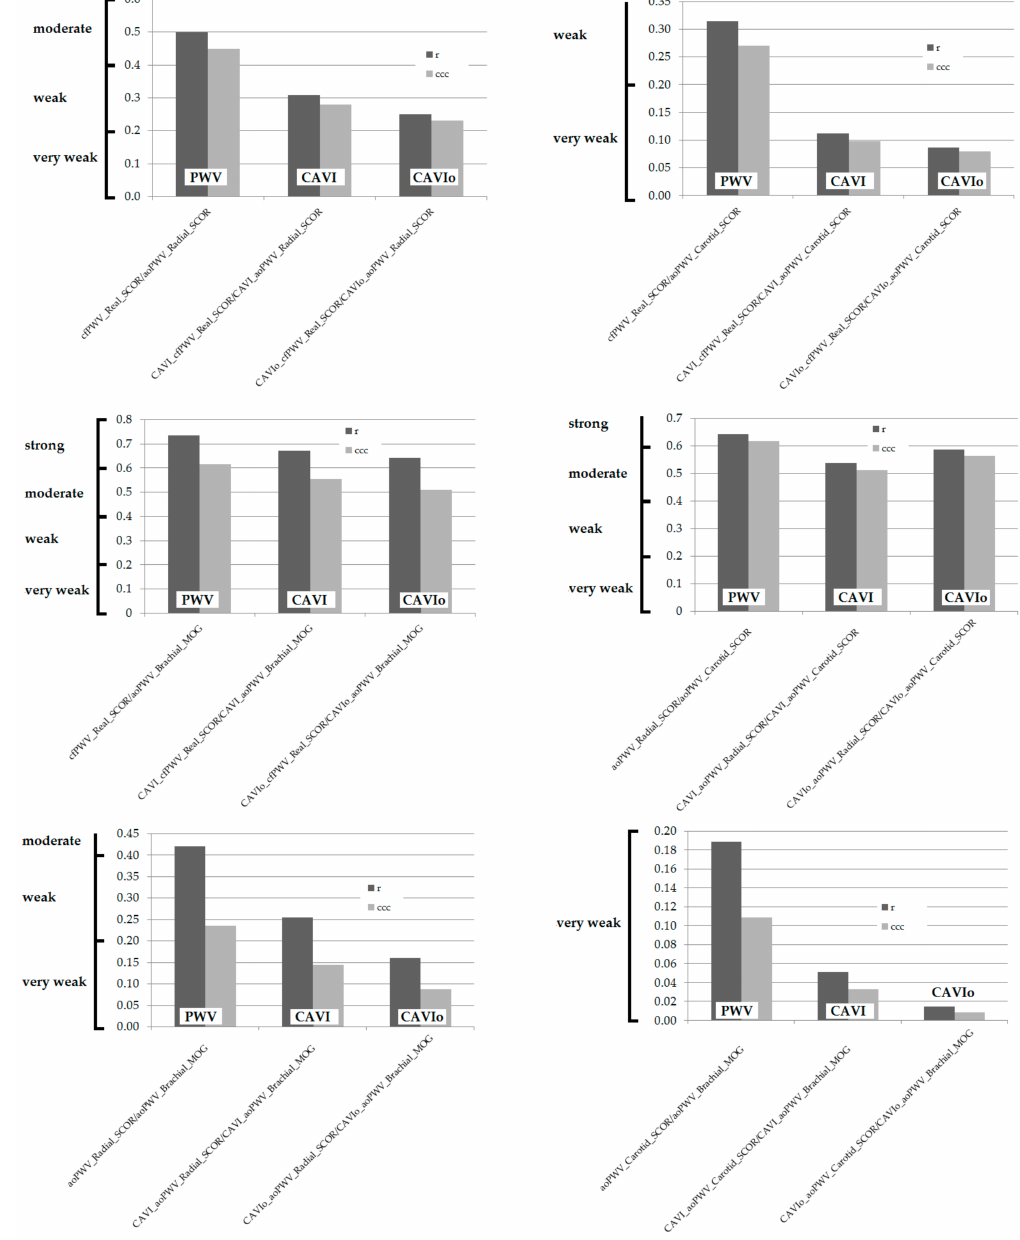
Figure 6. Simple (Pearson, r) and concordance correlation coefficients (CCCs) for PWV, CAVI and CAVIo, ordered for “pairs” of records. Evans’s Empirical Classifications of Interpreting Correlation Strength by Using r was applied: (i) very weak: <0.20; (ii) weak: 0.20–0.39, (iii) moderate: 0.40–0.59, (iv) strong: 0.60—0.79, (v) very strong: r ≥ 0.80